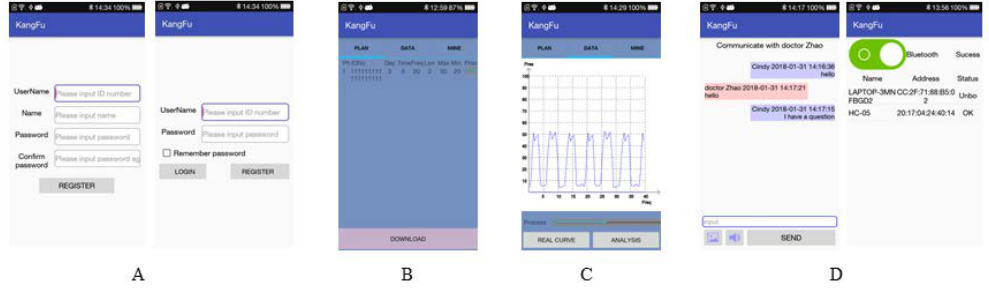
Figure 5. Illustrative images of the App interface. ( A ) Registration and Log; ( B ) Training plan; ( C ) Training data; ( D ) Mine.